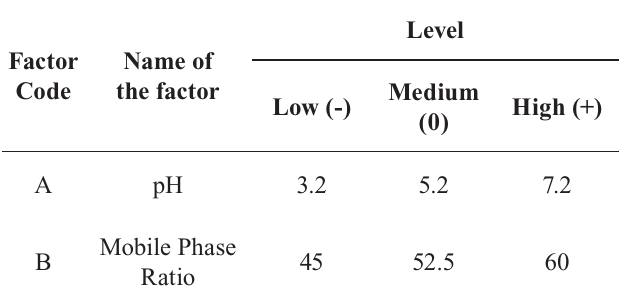
TABLE I - E xperimental factors and levels used in the central